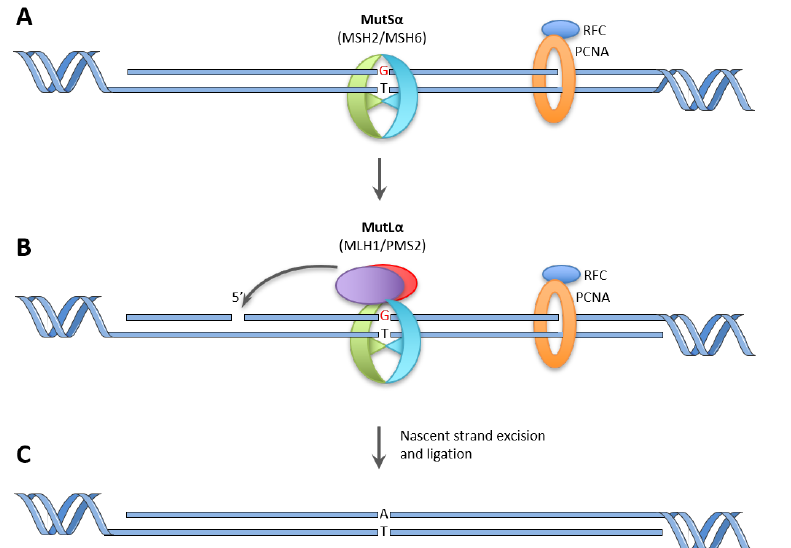
Figure 1. Overview of the mismatch repair pathway. ( A ) recognition of the mismatch by the MutSα. complex oriented by PCNA and RFC. ( B ) recruitment of the MutL α complex and nicking of the DNA 5’ to the mismatch by PMS2. ( C ) nascent strand excision and resynthesis, as well as final ligation of the nick.